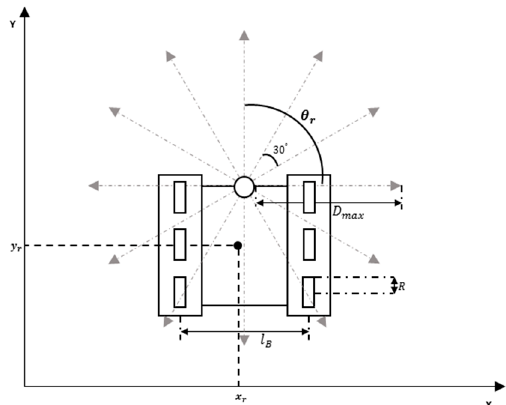
Figure 1. Schematic diagram of the tracked robot. Gray dash-dotted lines denote the senor lines of the robot.